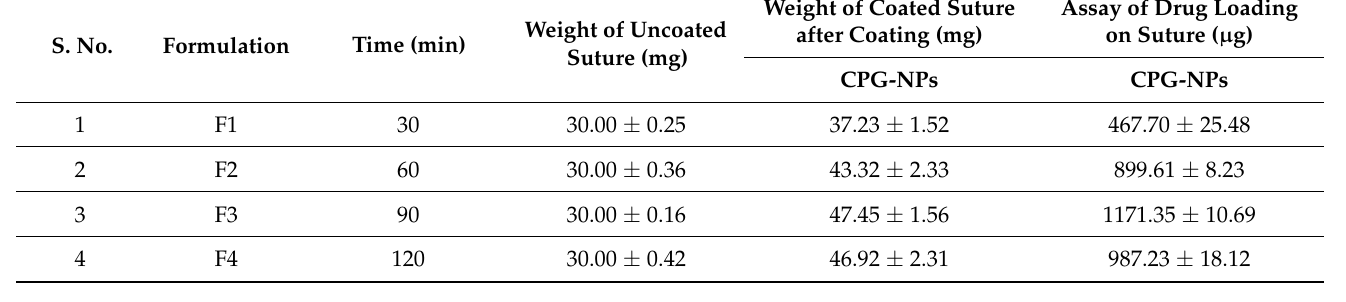
Table 2. Optimization of the contact time for drug loading on sutures ( n = 3).